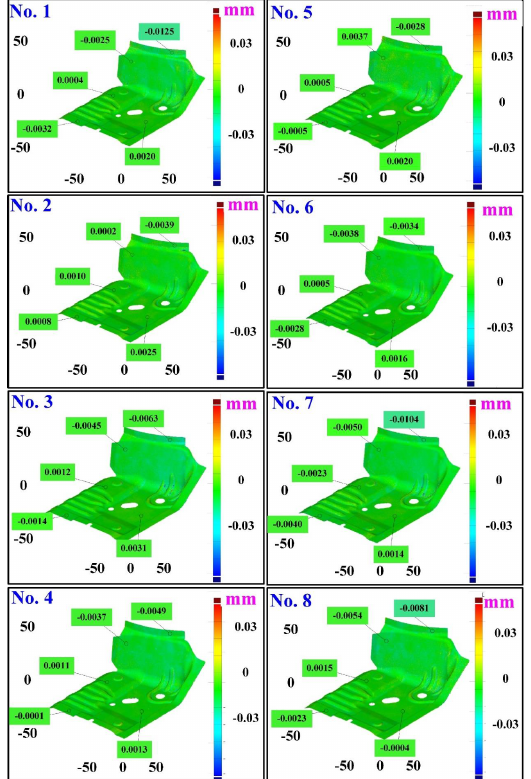
Figure 14. CAV results of the glossy sheet metal.